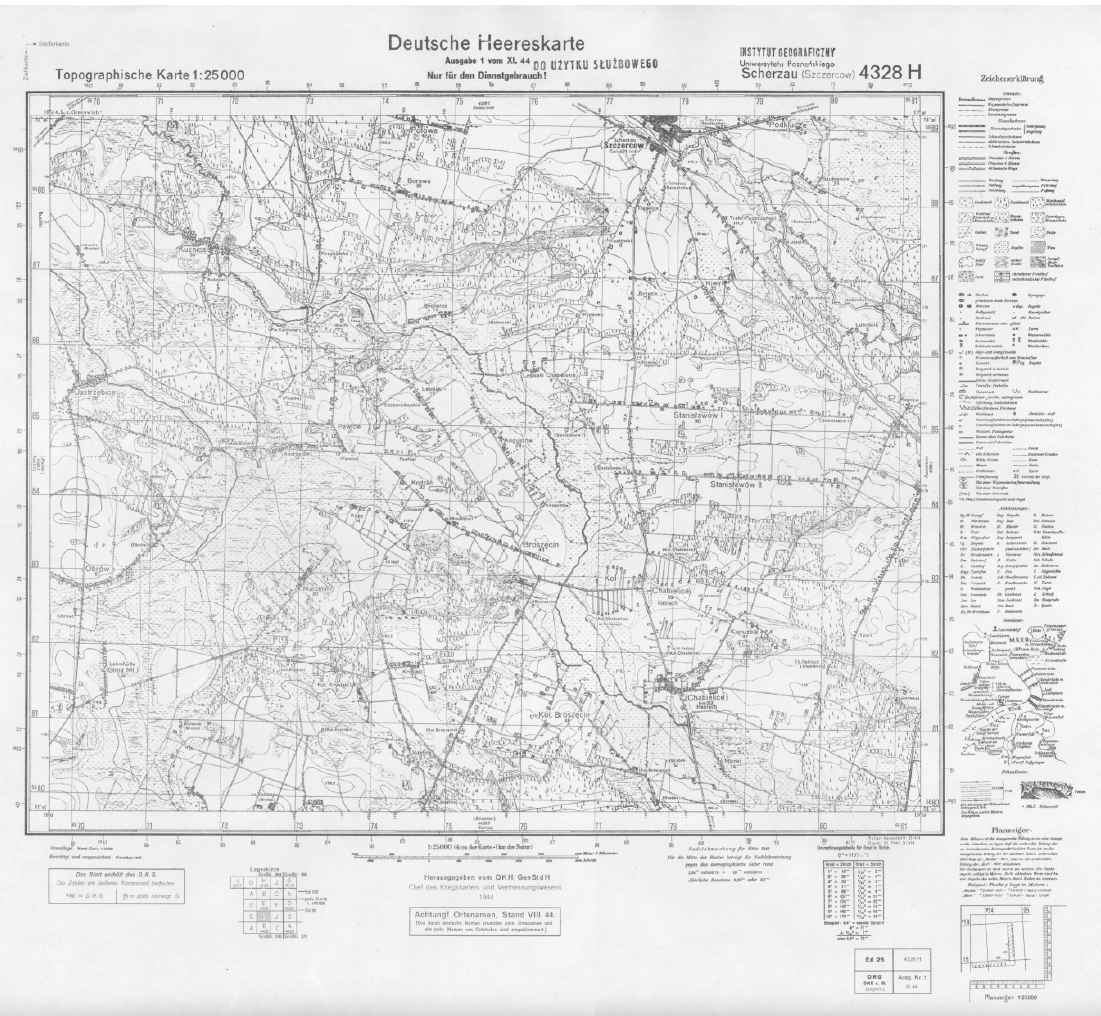
Figure 1. Sheet “Szczerców”—an example sheet used as the base map. Source: The Collection of the Cartographic Archive, Faculty of Geographical Sciences, AMU in Pozna ń .